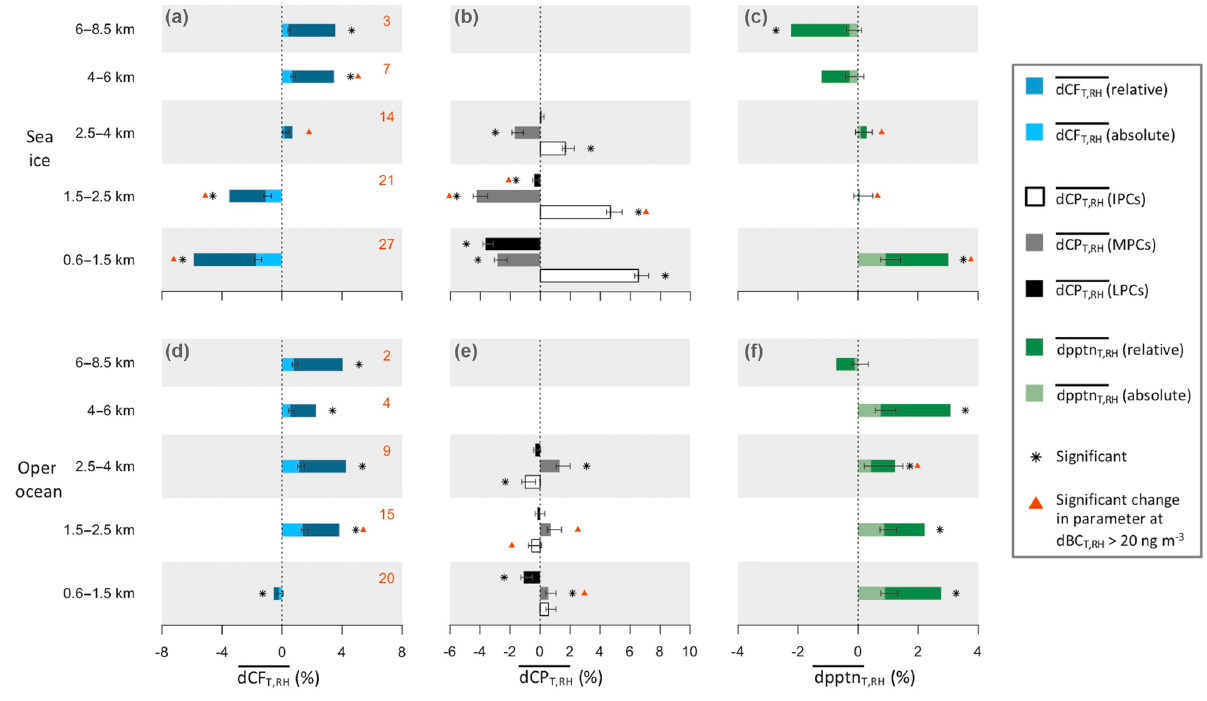
Figure 3. Summary of d CF T, RH , d CP T, RH (up to 4km, %), and d pptn T, RH (%) in different altitude ranges over sea ice and open ocean. For d CF T, RH and d pptn T, RH , different color bars (overlaid, not stacked) show the absolute change within the air volume of interest (lighter colors) and the relative percent change with respect to the value found in clean conditions (darker colors). The d BC T, RH values (ngm − 3 ) are presented for each altitude (red, upper right in a and d ). An asterisk (*) indicates that the differences between all and clean conditions were significant for both relative and absolute values, based on a paired Wilcoxon rank test, p <0.05, using T –RH grid cells containing >800 (400 for d CP T, RH ) 12.5km 2 gridded observations. Values marked by a red triangle indicate a significant change in the parameter where